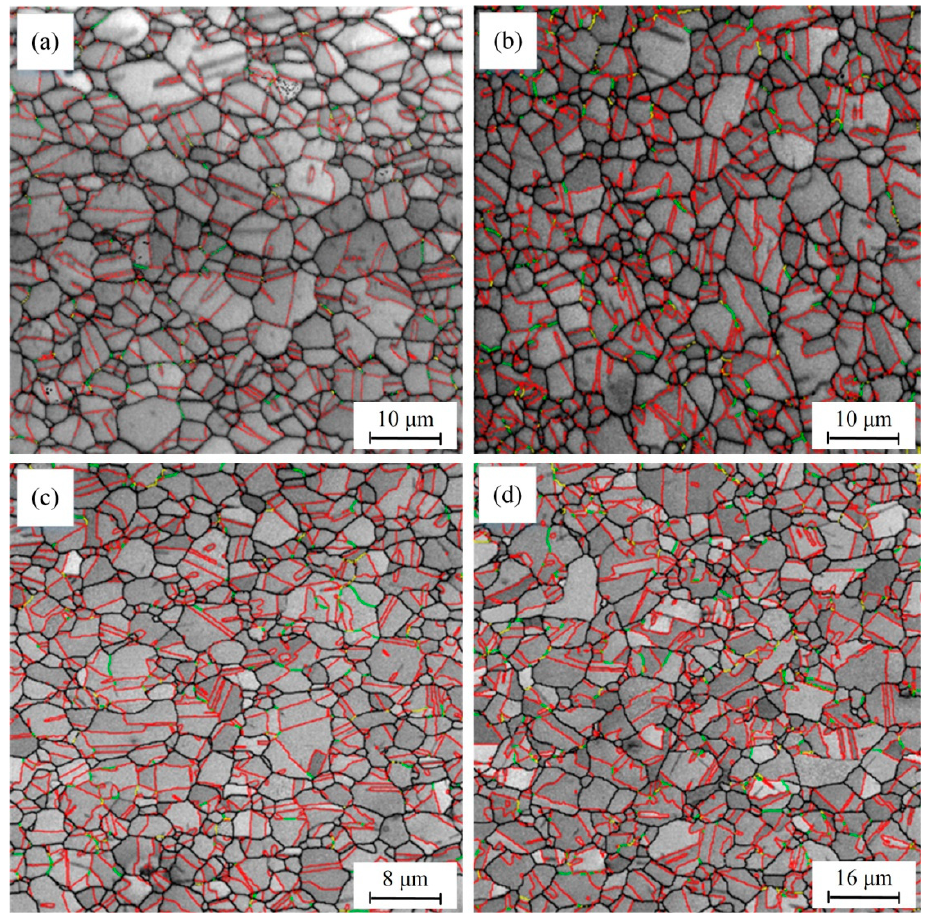
Figure 3. EBSD-IQ maps of the microstructure on the surface for the tested steel in ASHR process. ( a ) As-p1-60%-1, ( b ) As-p1-60%-2, ( c ) As-p3-83%-1, ( d ) As-p3-83%-2. Red line indicate the anealing twin boundary, black line indicate the large angle grain boundary, green line indicate the Σ 9 grain boundary, yellow line indicate the Σ 27 grain boundary.